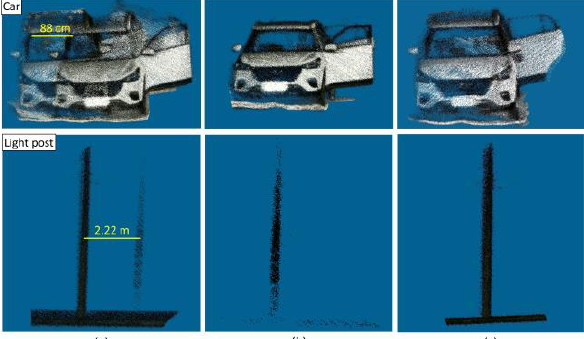
Figure 9. Details of objects (car and light post) in the point cloud obtained with datasets (a) I, (b) II and (c)